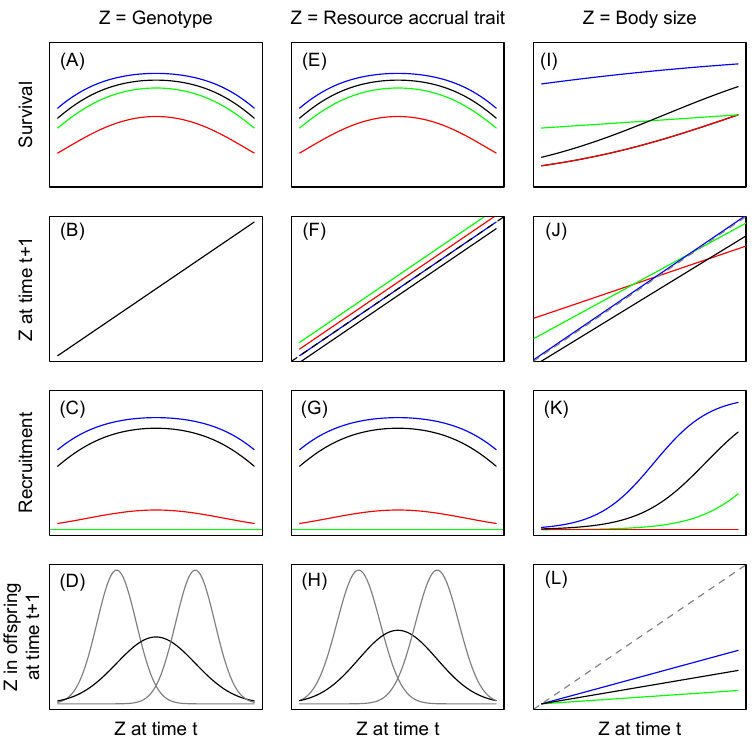
Figure 3. The form of survival (A, E, I), development (B, F, J), reproduction (C, G, K) and inheritance (D, H, L) functions for different individual attribute types. (A-D) form of functions for a breeding value or genotype that is subject to stabilizing viability (A) and fertility (C) selection, that does not develop throughout life (B), and exhibits genetic inheritance (D). The two narrower grey distributions in